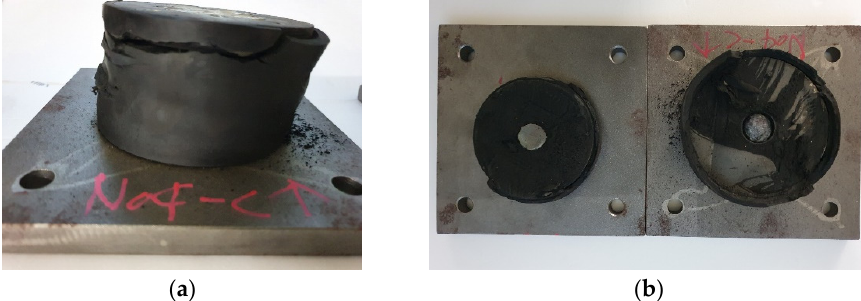
Figure 18. View of the LRB failure surface after break: ( a ) front view; ( b ) top view.